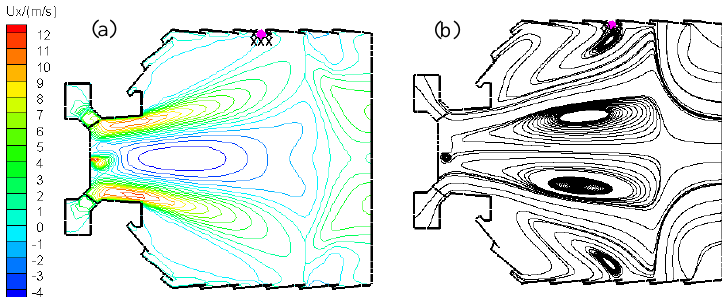
Figure 9. ( a ) Axial velocity and ( b ) streamline distribution.